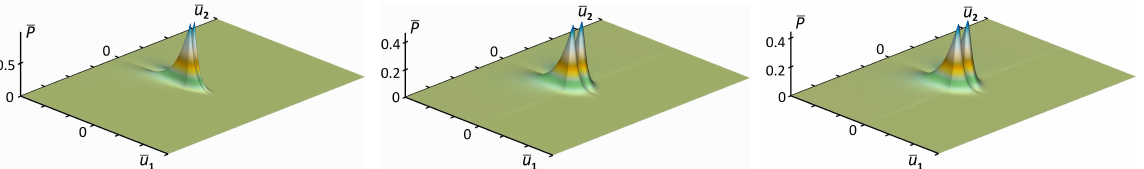
Figure 1. The different stages of the evolution of the free fields of the environment, respectively, at t 1 = 1.5, t 2 = 10 and t 3 = 20. Note that these distributions were calculated using the data from the first row of the table, which corresponds to weak elastic and inelastic processes in the environment. Comparing the distributions at different times, it is easy to see that as t ∼ 10, the distribution ¯ P ( u ) normalized to unity is established or tends to its stationary limit. 1 , u 2 , t